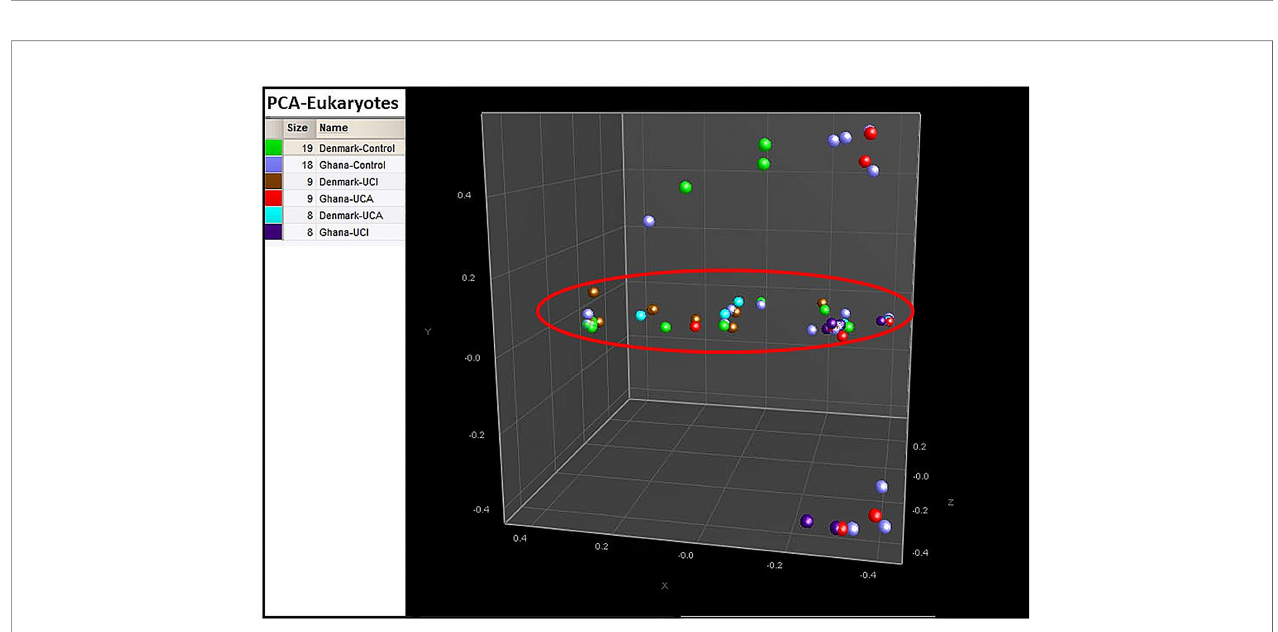
FIGURE 5 | PCA is based on the cluster analysis; 85% of the Danish healthy controls are gathered in the red circle, while healthy controls from Ghana and patient groups are spread all over the PCA.